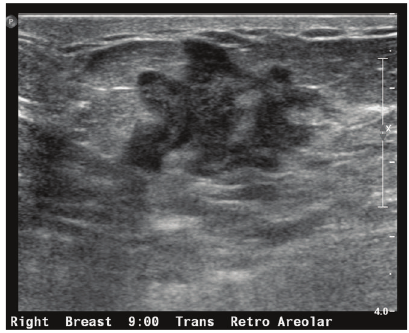
Figure 2: Focused ultrasound of the right breast in the retroare- olar region better demonstrates the biopsy-proven invasive breast cancer.